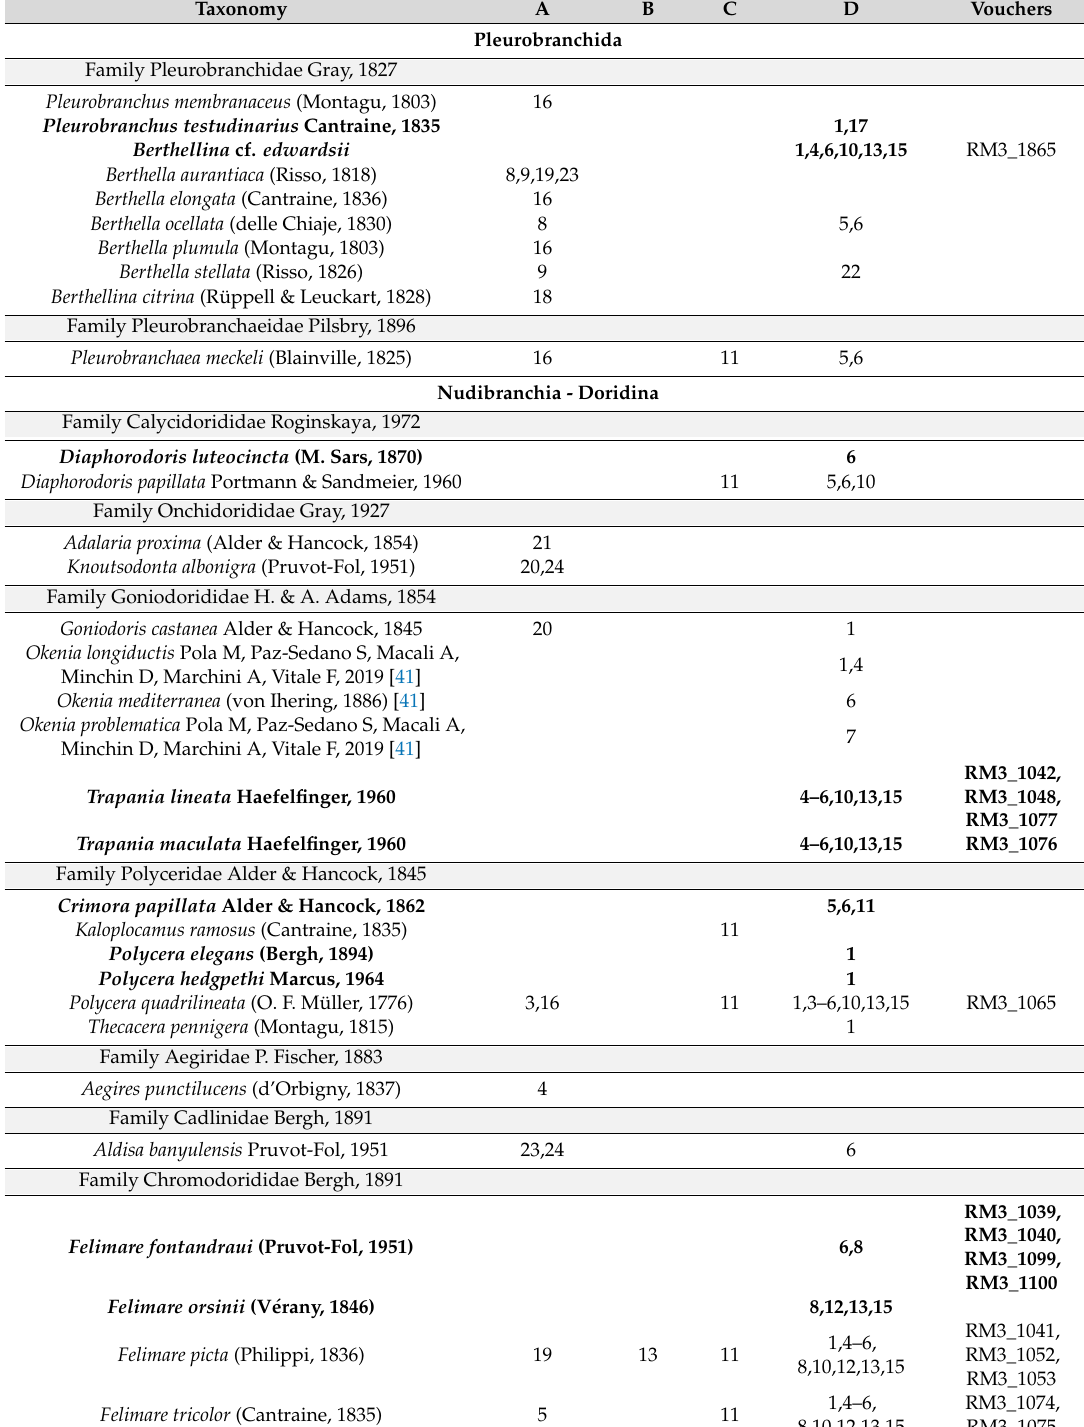
Table 2. List of species of Heterobranchia occurring around the Salento peninsula; localities are numbered according to Figure 1, with new records in column D, highlighted in bold. Column A = Perrone [30–37]; B = Onorato and Belmonte [38]; C = Micaroni et al. [39]; and D = Present